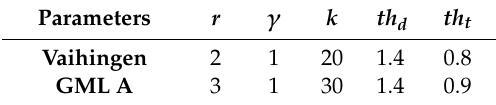
Table 6. The Parameter configuration of Algorithm 2 for Vaihingen Dataset and GML Dataset A.